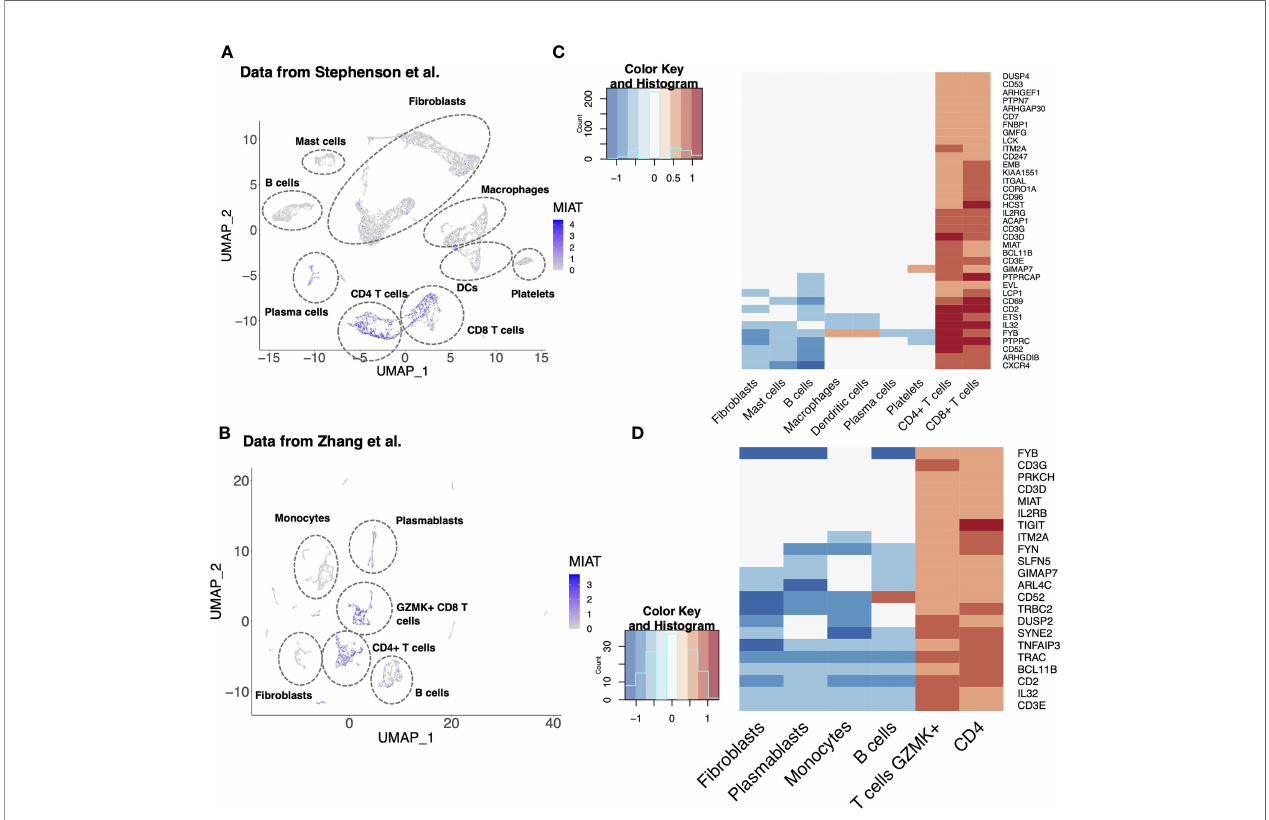
FIGURE 6 | MIAT Is Highly Expressed in the Synovial T Cells of Rheumatoid Arthritis Patients. (A, B) MIAT expression in RA synovium. Reanalysis of scRNA-seq data of RA synovium from Stephenson et al. (A) and Zhang et al. (B) showing MIAT expression in different cell-type clusters. The expression was visualized using Uniform Manifold Approximation and Projection ( UMAP ), where each point represents a single cell. (C, D) Top genes co-expressed with MIAT in RA synovium. Reanalysis of scRNA-seq analysis from Stephenson et al. (C) and Zhang et al. (D) . Gene expression is displayed in log2FC. The color key indicates upregulation (red) or downregulation